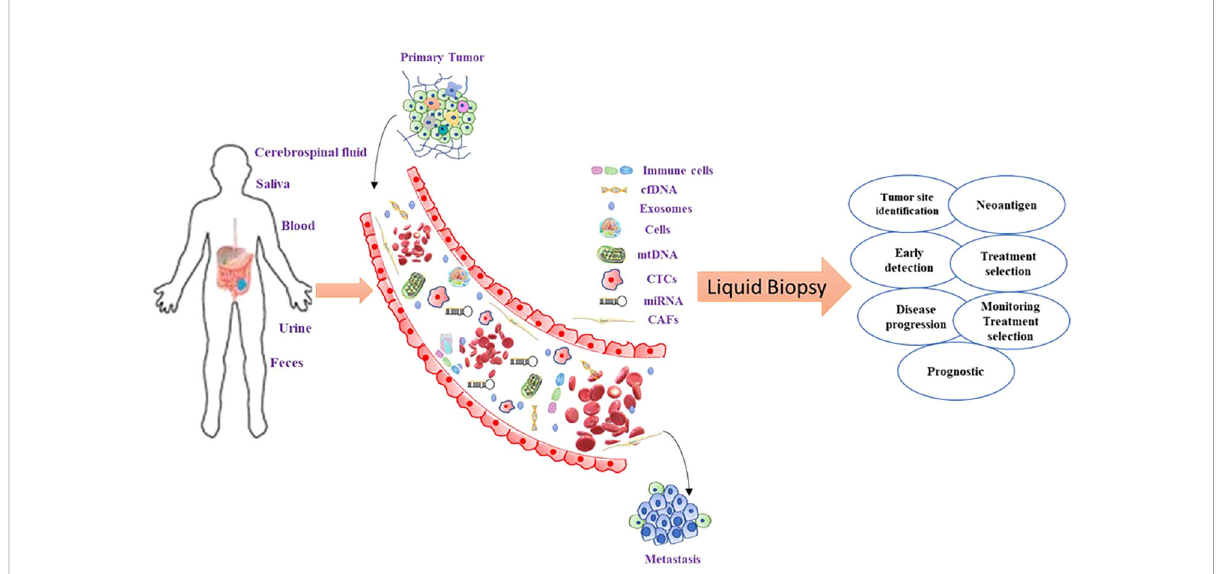
FIGURE 1 Liquid biopsy components in CRC and their clinical utility. CTCs are shedded from the tumor into the blood vessels where they can release their components: nucleic acids and exosomes with tumor-speci fi c cargo material. For the analysis of these molecules, blood can be taken out, and plasma or serum further processed for the extraction of the desired constituents. From the blood circulation, these molecules can be fi ltered into saliva and urine which can also be collected and further analyzed. Each of these constituents delivers one or more levels of tumor information. The quantity of the concentration of single proteins or panels including numerous tumor proteins is the present gold standard in cancer